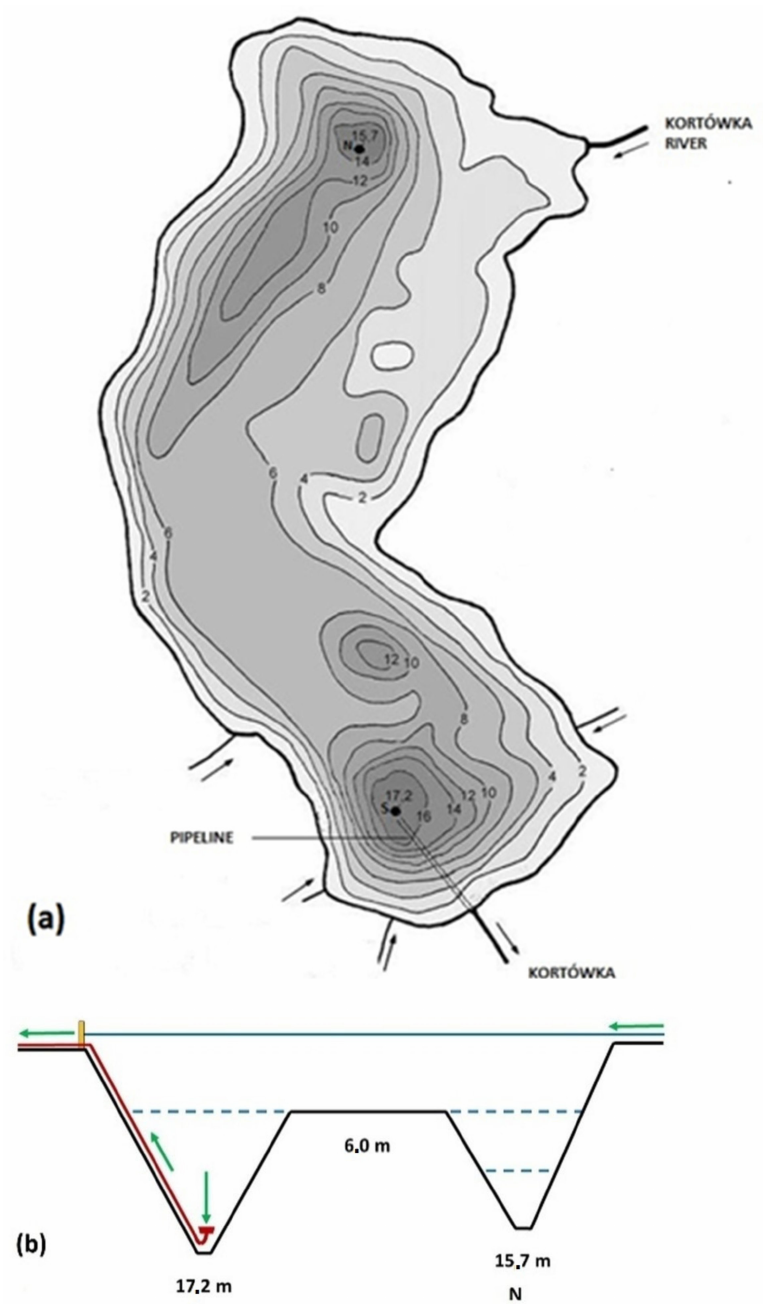
Figure 1. Study area and sampling site locations (S—the site in the southern basin of the lake, where the pipeline is located; N—the site in the northern basin of the lake) ( a ) and the cross section of Lake Kortowskie ( b